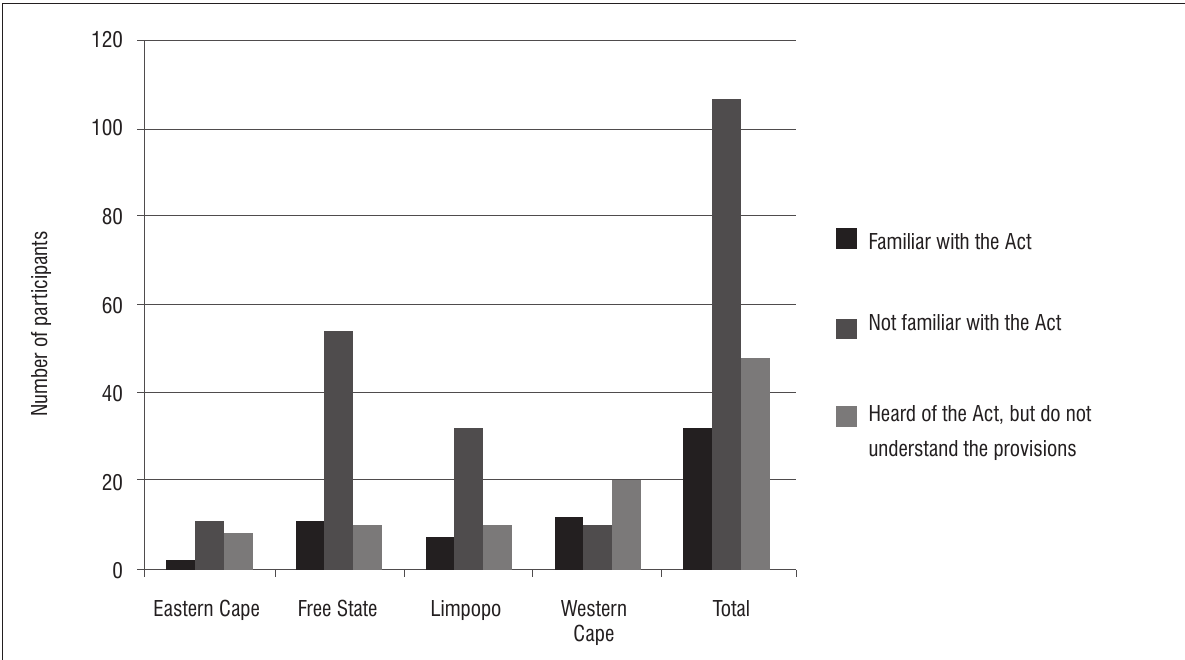
Figure 1: Familiarity with the Plant Breeders’ Rights Act among participants from different provinces.